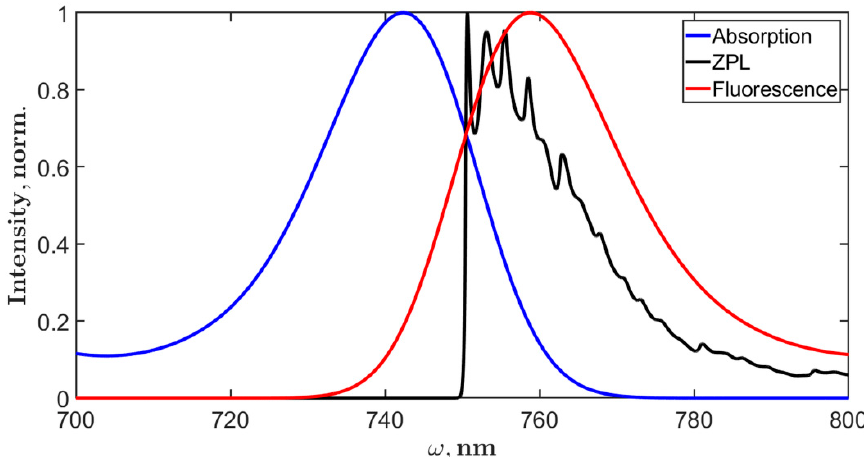
Figure 7. Calculated zero phonon line (ZPL), absorption, and fluorescence of F760 emitter. The shape of ZPL corresponds to the strong electron-phonon coupling. The inhomogeneous broadening is 200 cm − 1 . The resulting Stokes shift is about 20 nm.